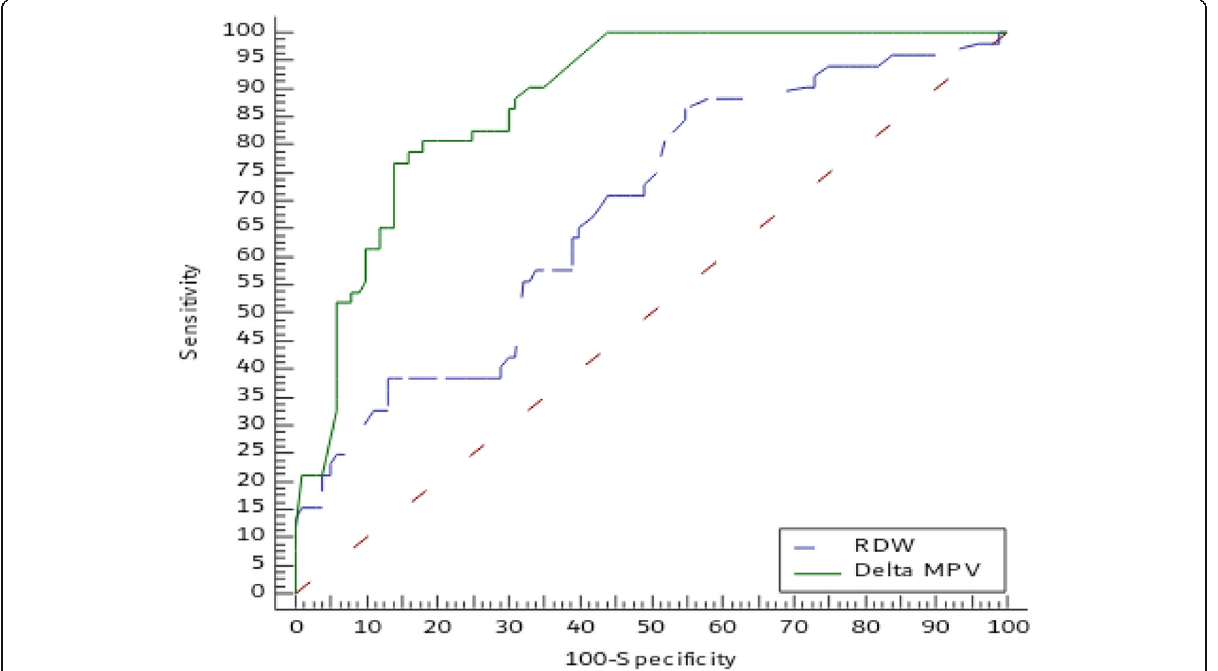
Fig. 6 Diagnostic performance of delta MPV and RDW in prediction of in-hospital